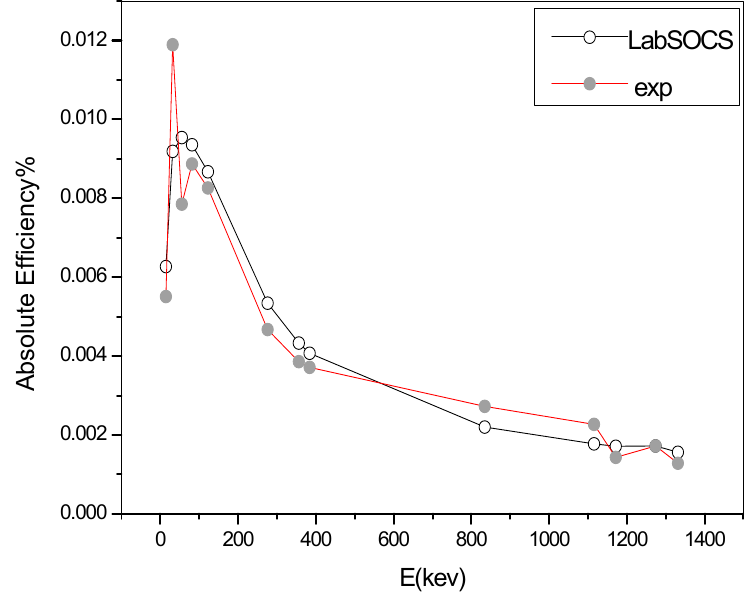
Figure 2. Efficiency validation. Figure 2. E ffi ciency validation.